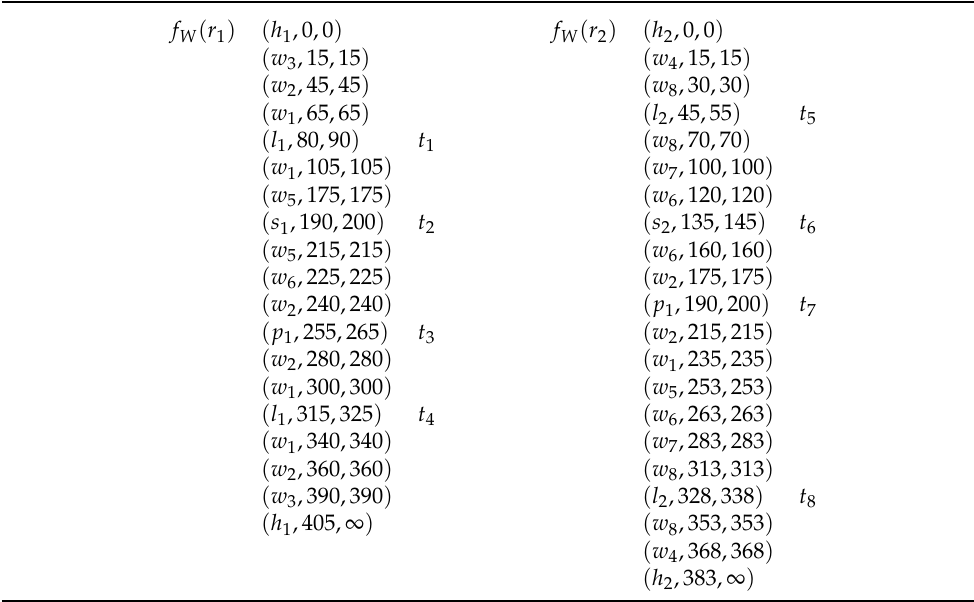
Table 2. Timed walks of robot r 1 and r 2 taking 18 and 20 steps,